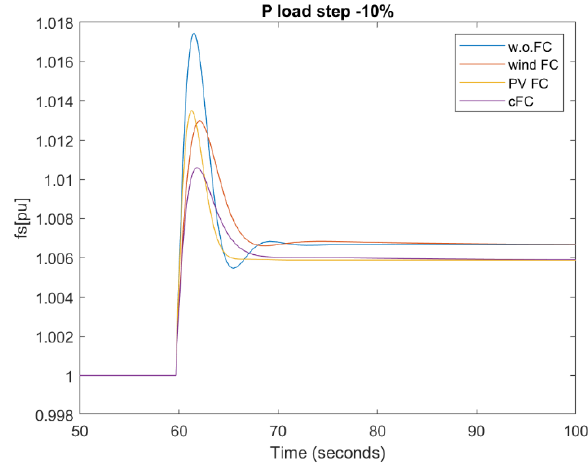
Figure 14. Simulation 4 frequency trend.